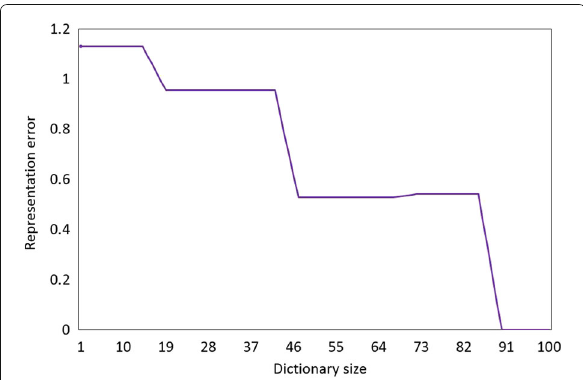
Fig. 4 Representation error for different dictionary